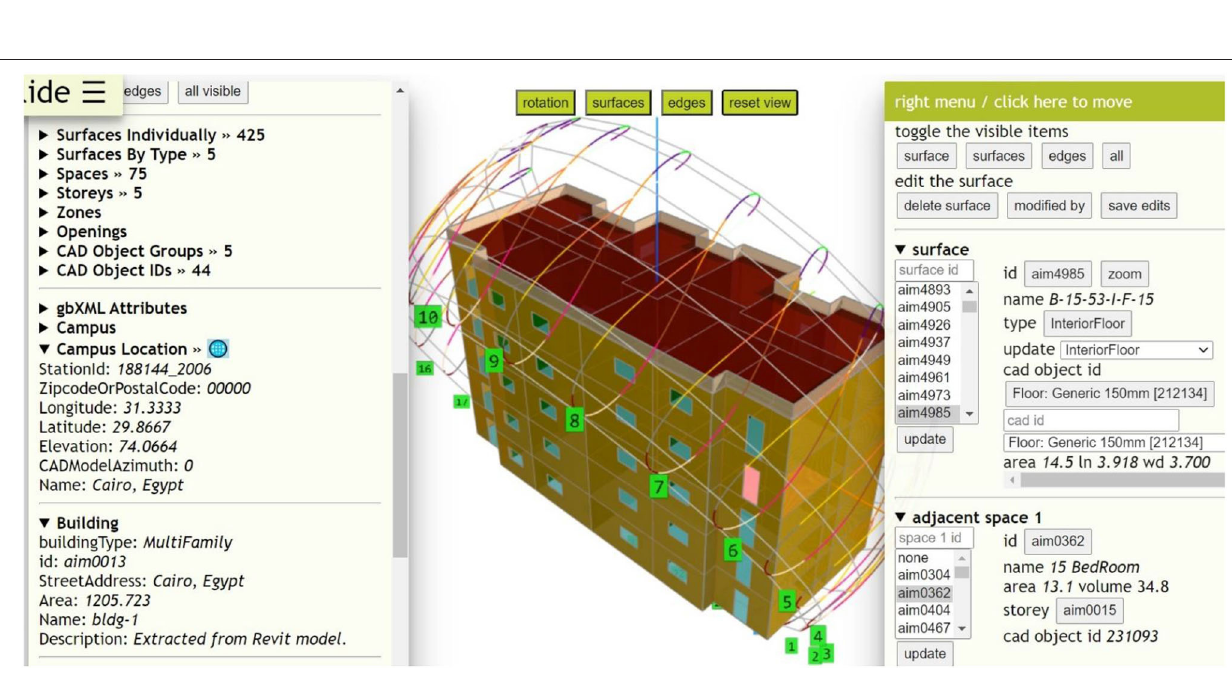
FIGURE 9 | Aragog gbXML model viewer